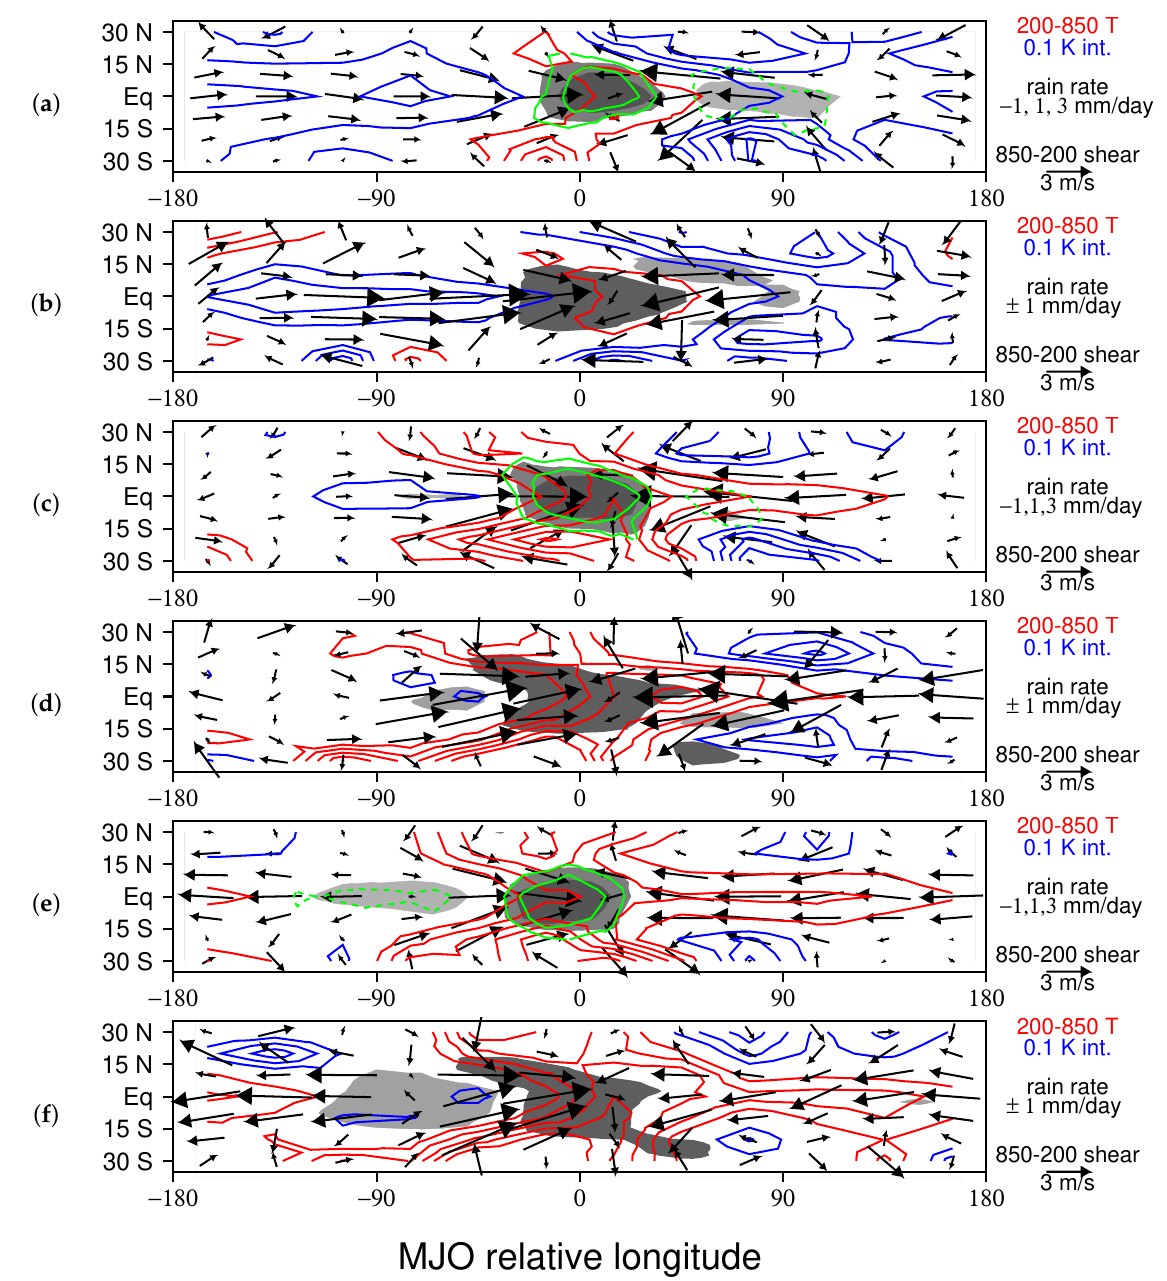
Figure 2. Average 200–850 hPa temperature (red and blue contours) and the difference between 850 and 200 hPa flow (vectors) for the composite LAM MJO ( a , c , e ) and the observed MJO ( b , d , f ) for the developing, mature, and dissipating stages of the convective envelope, respectively. For the LAM, MJO regions of perturbation rainfall less than − 1 mm/day are shaded light gray, and areas with rainfall greater than 1 and 3 mm/day are shaded medium and dark gray, respectively. Green contours indicate budget-derived rainfall rates of 1 and 3 mm/day, respectively. Observed MJO regions of rainfall less than − 1 and more than 1 mm/day are shaded light and dark gray, respectively (adapted from